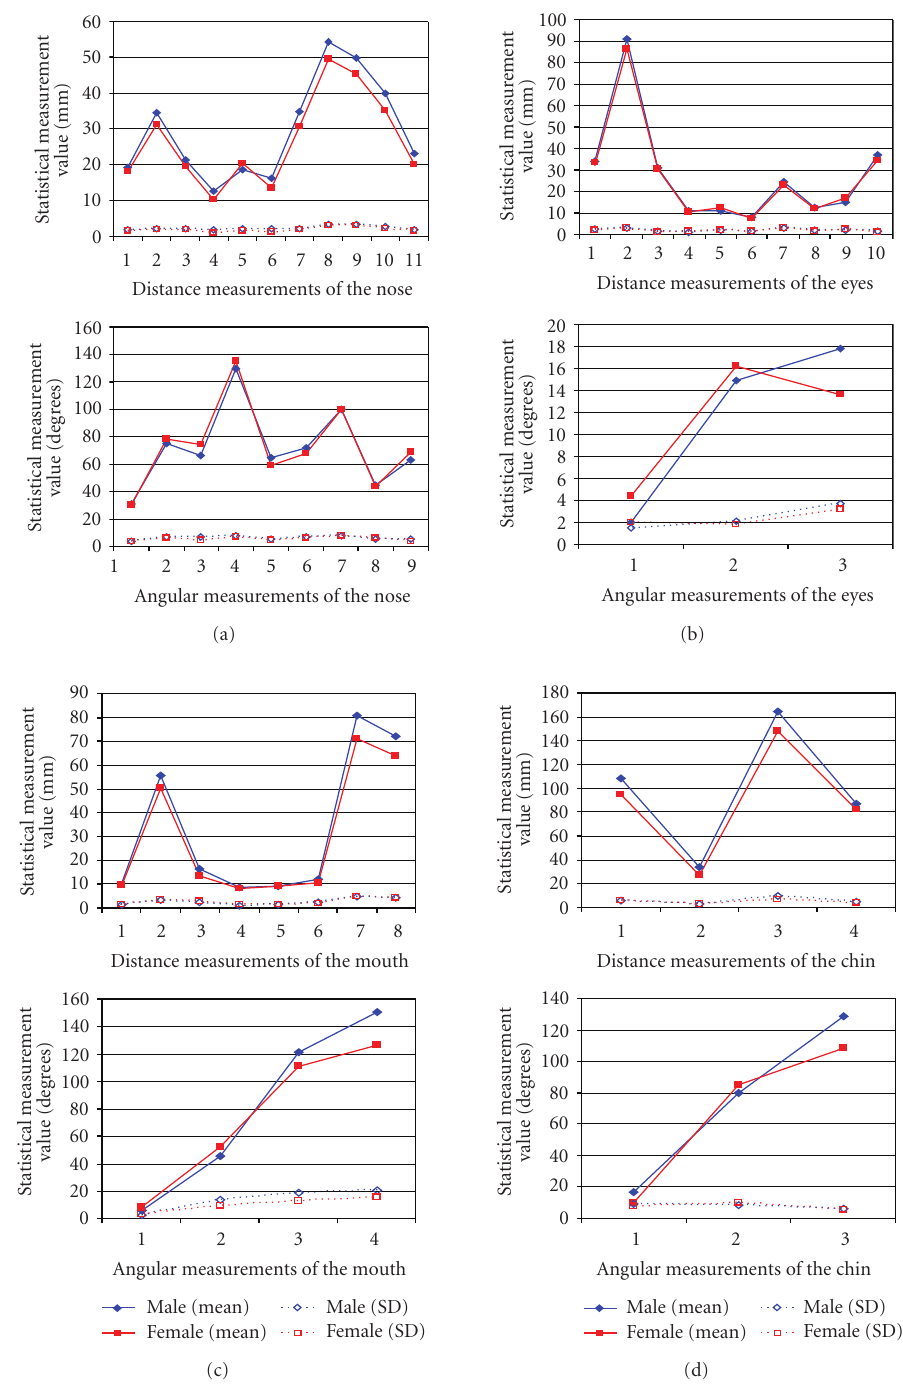
Figure 14: Comparison of statistics of facial feature measurements between genders (females in red and males in blue). Each facial feature: statistics of the distance measurements (top) and statistics of the angular measurements (bottom).